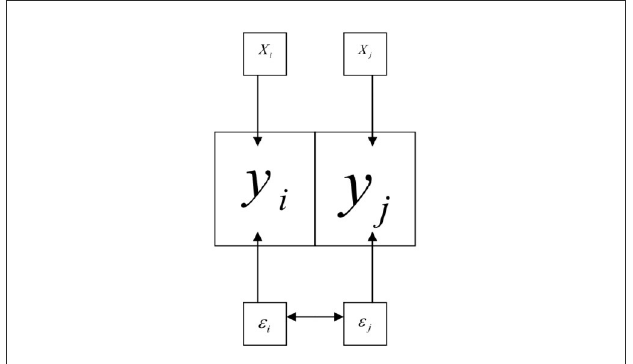
FIGURE1 The figure shows the scheme of the spatial error model (Catma, 2021).